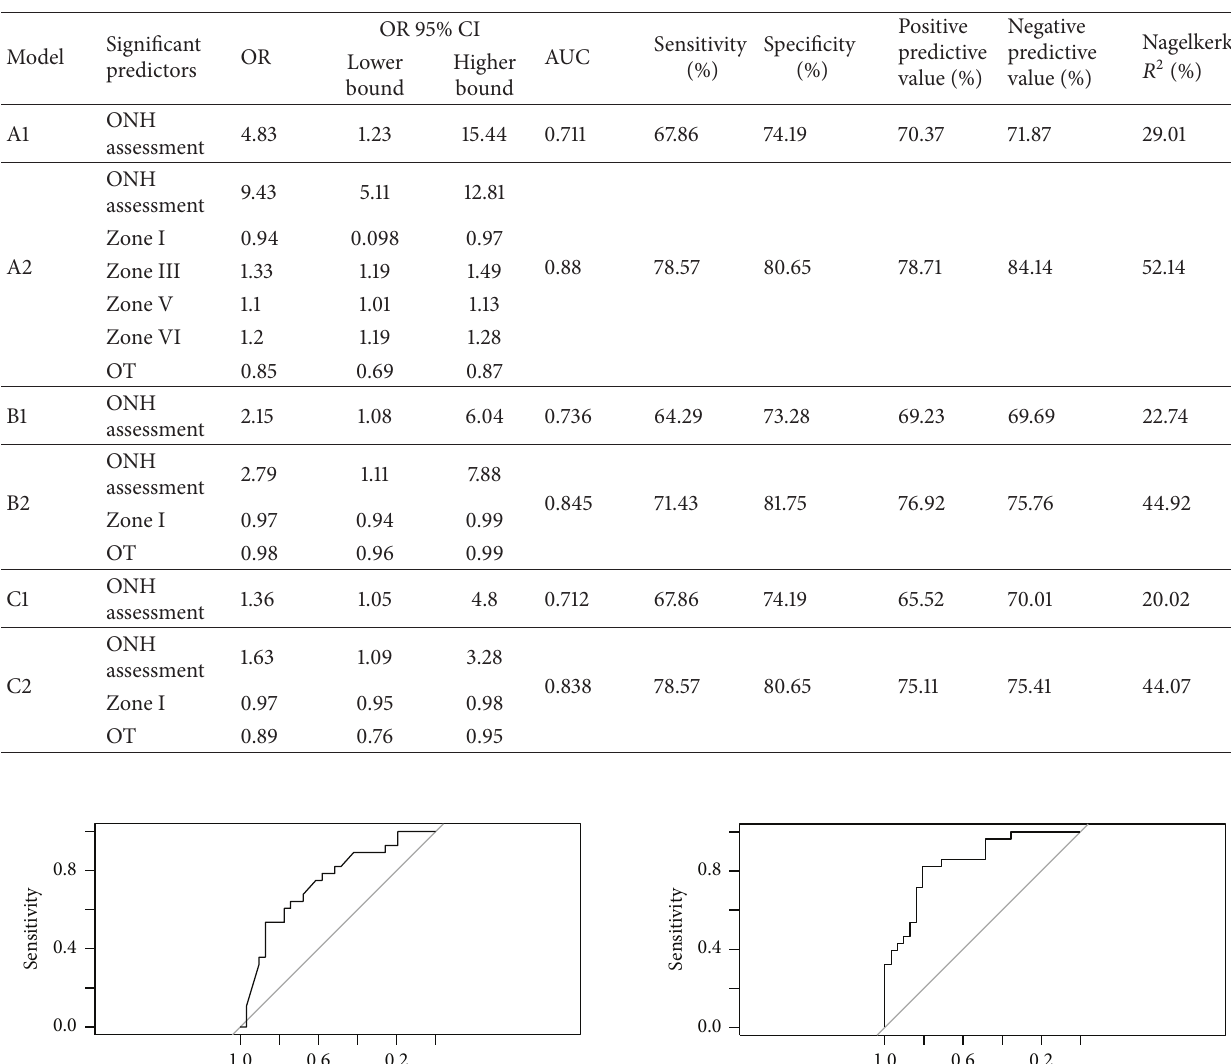
Table 2: Parameters showing the diagnostic ability of each significant variable in each model, respectively, (OR: odds ratio) and the diagnostic capacity of each model (sensitivity, specificity, positive and negative predictive values, AUC of ROC curves, and Nagelkerke 𝑅 2 ).